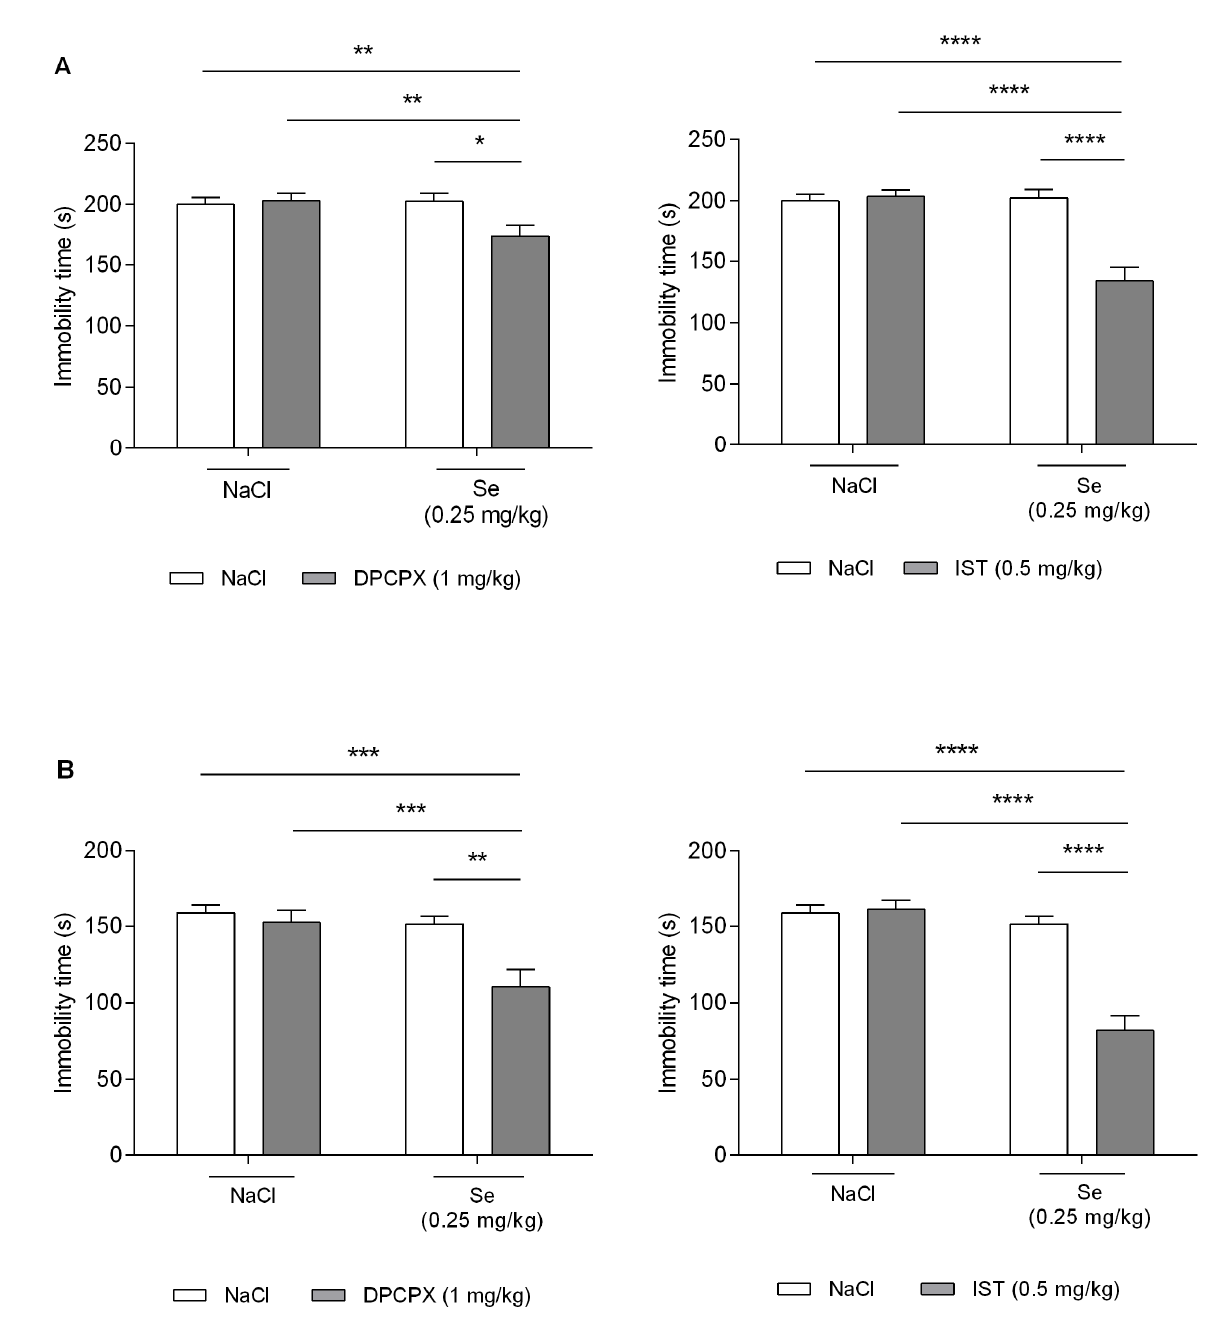
Figure 2. Effect of combined administration of sodium selenite and selective adenosine receptor antagonists in the FST ( A ) and the TST ( B ) in mice. DPCPX, sodium selenite (Se), and NaCl 0.9% were administered i.p. 30 min, while IST was administered p.o. 60 min prior to behavioral testing. Data are presented as the means ± SEM. Each experimental group consisted of 8–10 mice. * p < 0.05, ** p < 0.01, *** p < 0.001, **** p < 0.0001 vs. respective group (two-way ANOVA followed by Bonfer- roni’s post-hoc test).